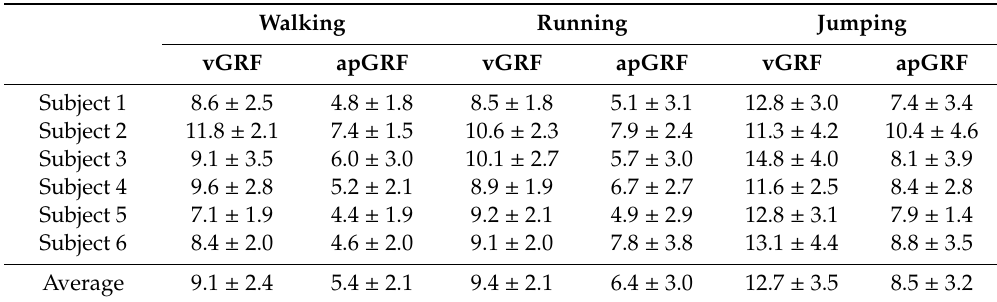
Table 1. Normalized root mean square errors (NRMSEs) of the vertical and anterior-posterior ground reaction forces (vGRF and apGRF, respectively) depending on the subjects during walking, running, and jumping (unit in %) ( p -values <